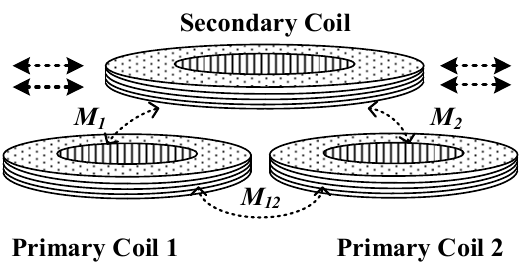
Figure 7. The diagram of coupling coefficients